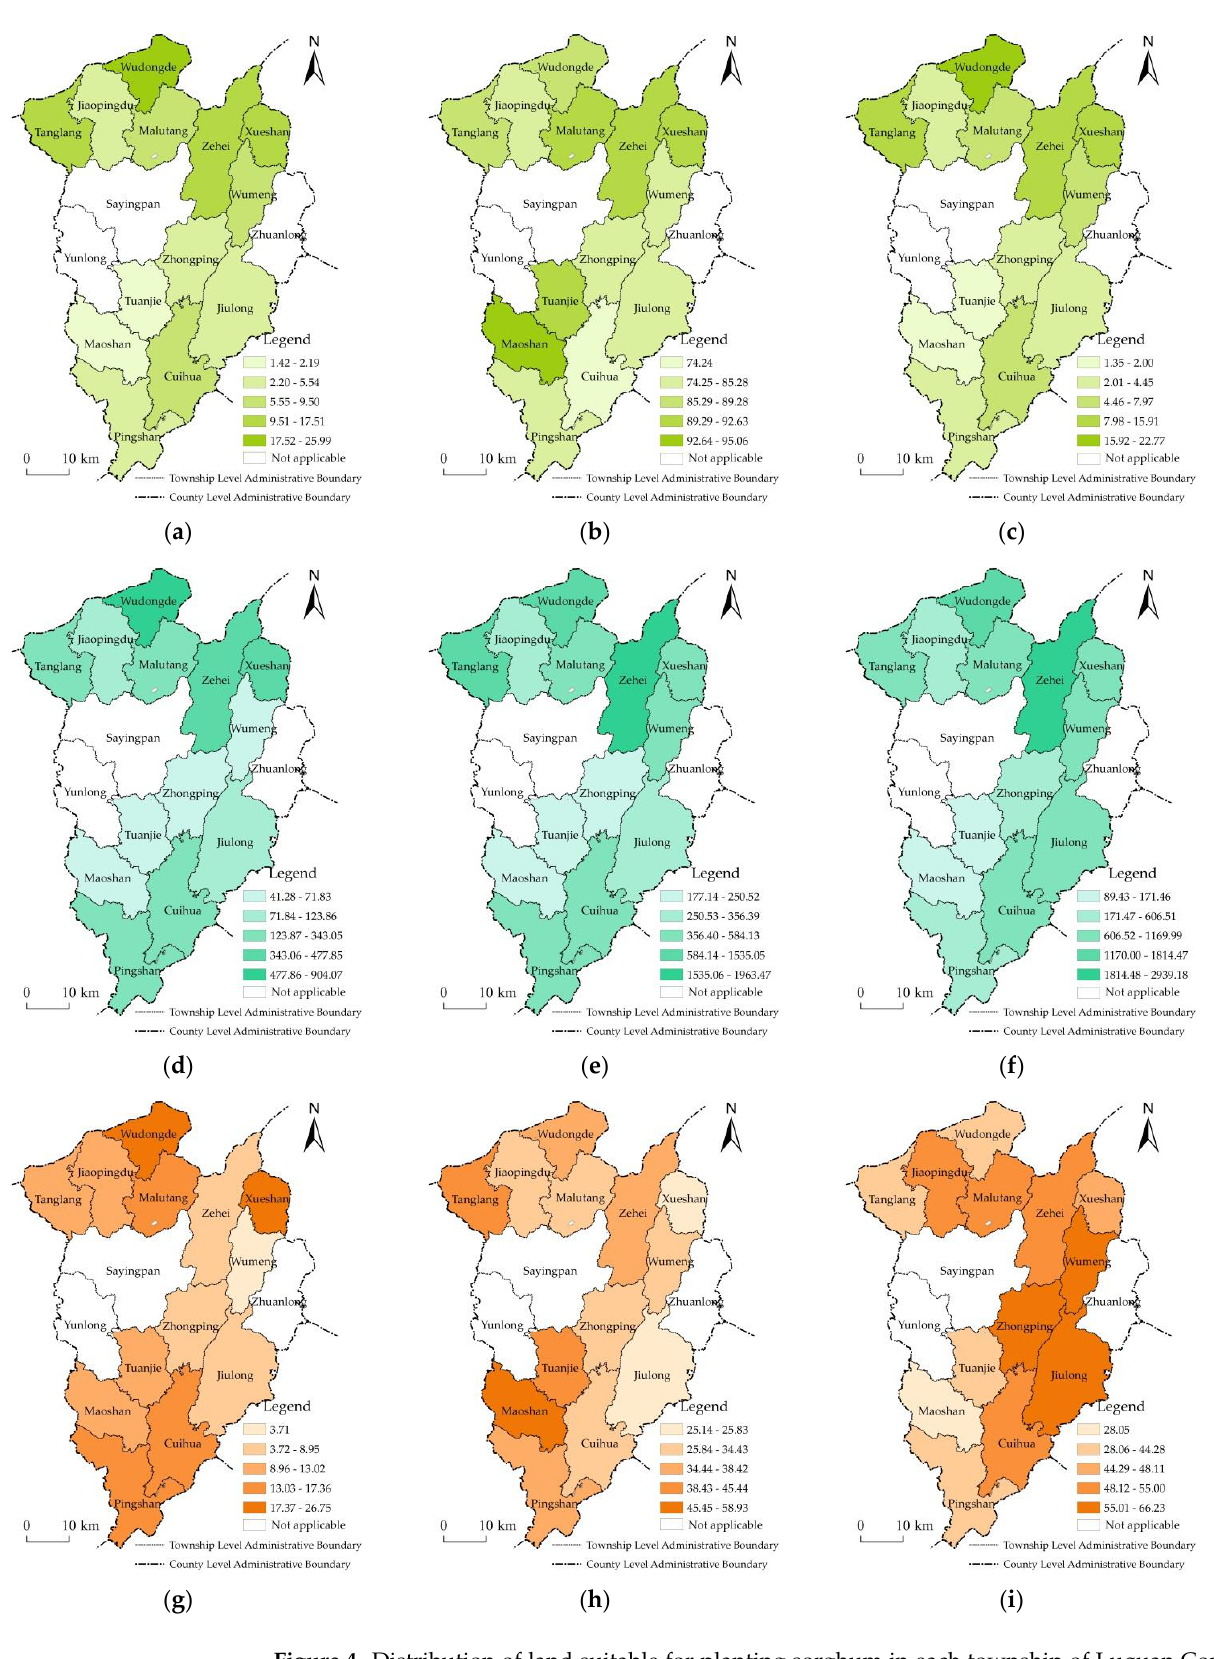
Figure 4. Distribution of land suitable for planting sorghum in each township of Luquan County. ( a ) Proportion of the evaluation scope of the land suitable for planting sorghum to the total land area in Luquan County (Unit: %); ( b ) proportion of land suitable for planting sorghum in the